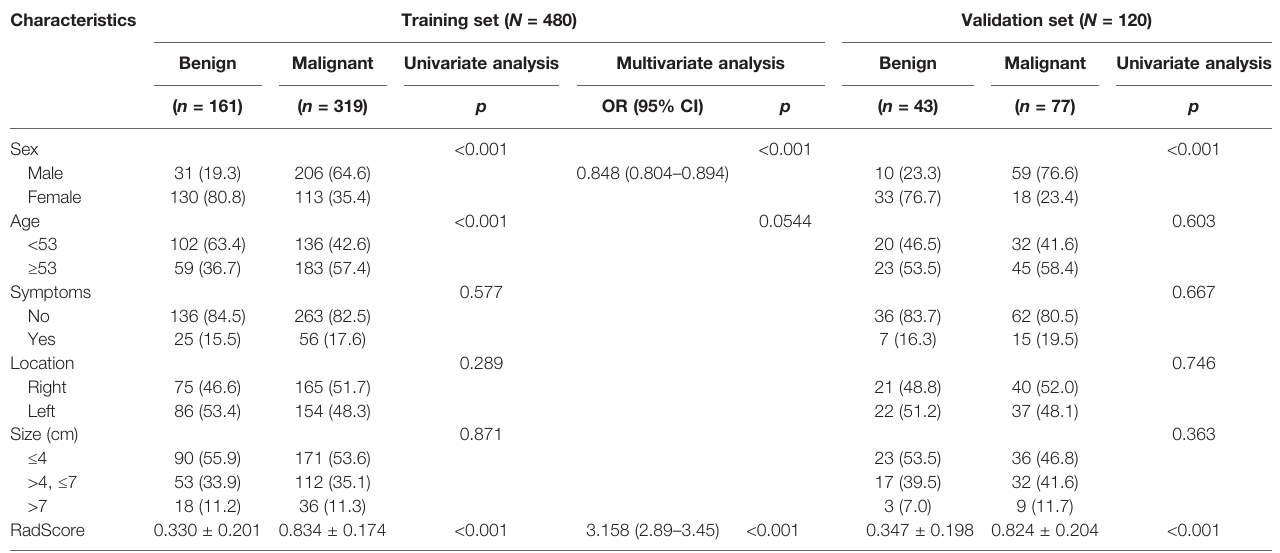
TABLE 1 | Clinical characteristics of patients in the training and validation sets.